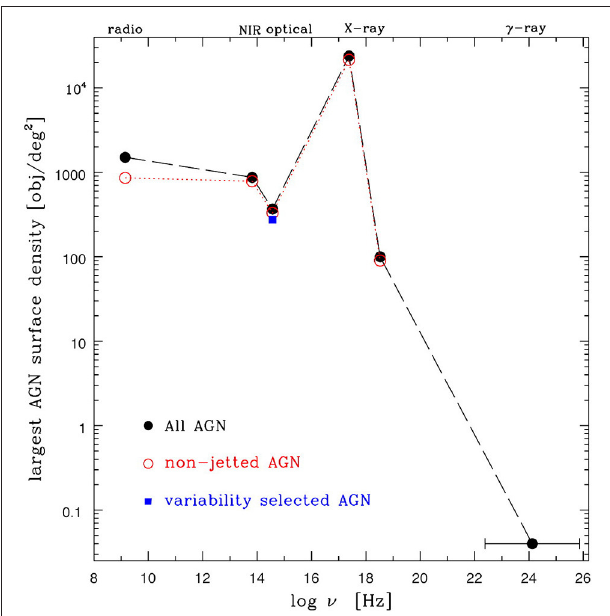
FIGURE 3 | The largest AGN surface density over the whole electromagnetic spectrum. Black filled points refer to all AGN, open red points are for non-jetted AGN. The latter are actually directly measured only in the radio band, while in the NIR to X-ray bands they have been derived by simply subtracting 10% from the total values. Non-jetted AGN have not been detected in the γ -ray band. The blue square indicates variability selected AGN. Updated from Figure 11 of Padovani (2016), where one can find the references to the relevant samples and facilities, to include variability selected AGN and the results of the CDFS 7 Ms sample ( Luo et al., 2017). Figure reproduced from Padovani et al. (2017), Figure 21, with permission of